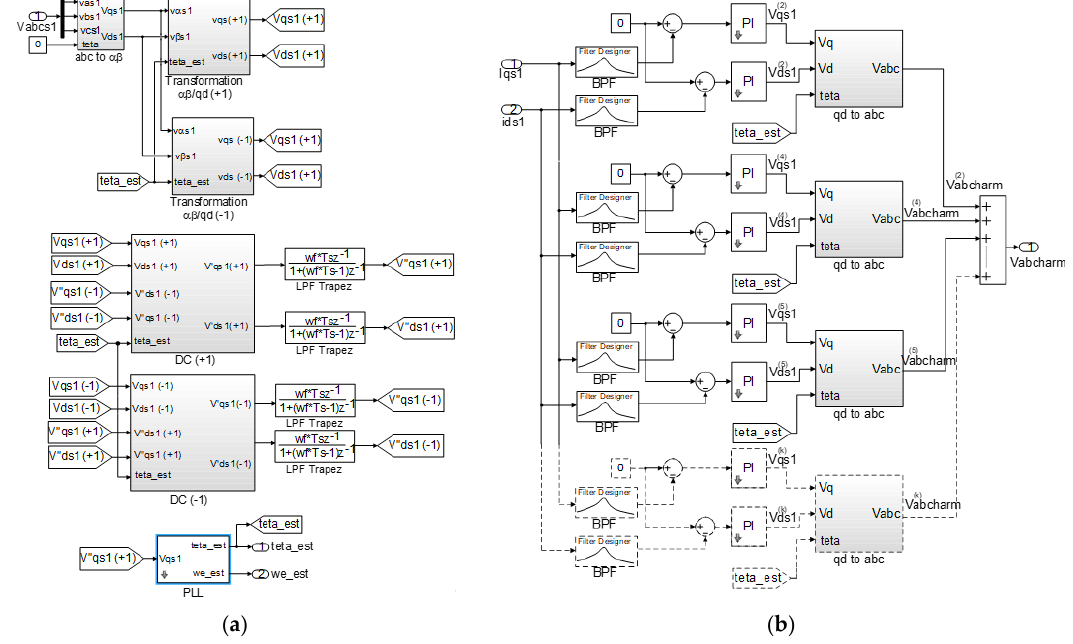
Figure 6. Simulink block diagram of the: ( a ) MSF algorithm and ( b ) harmonics compensation.